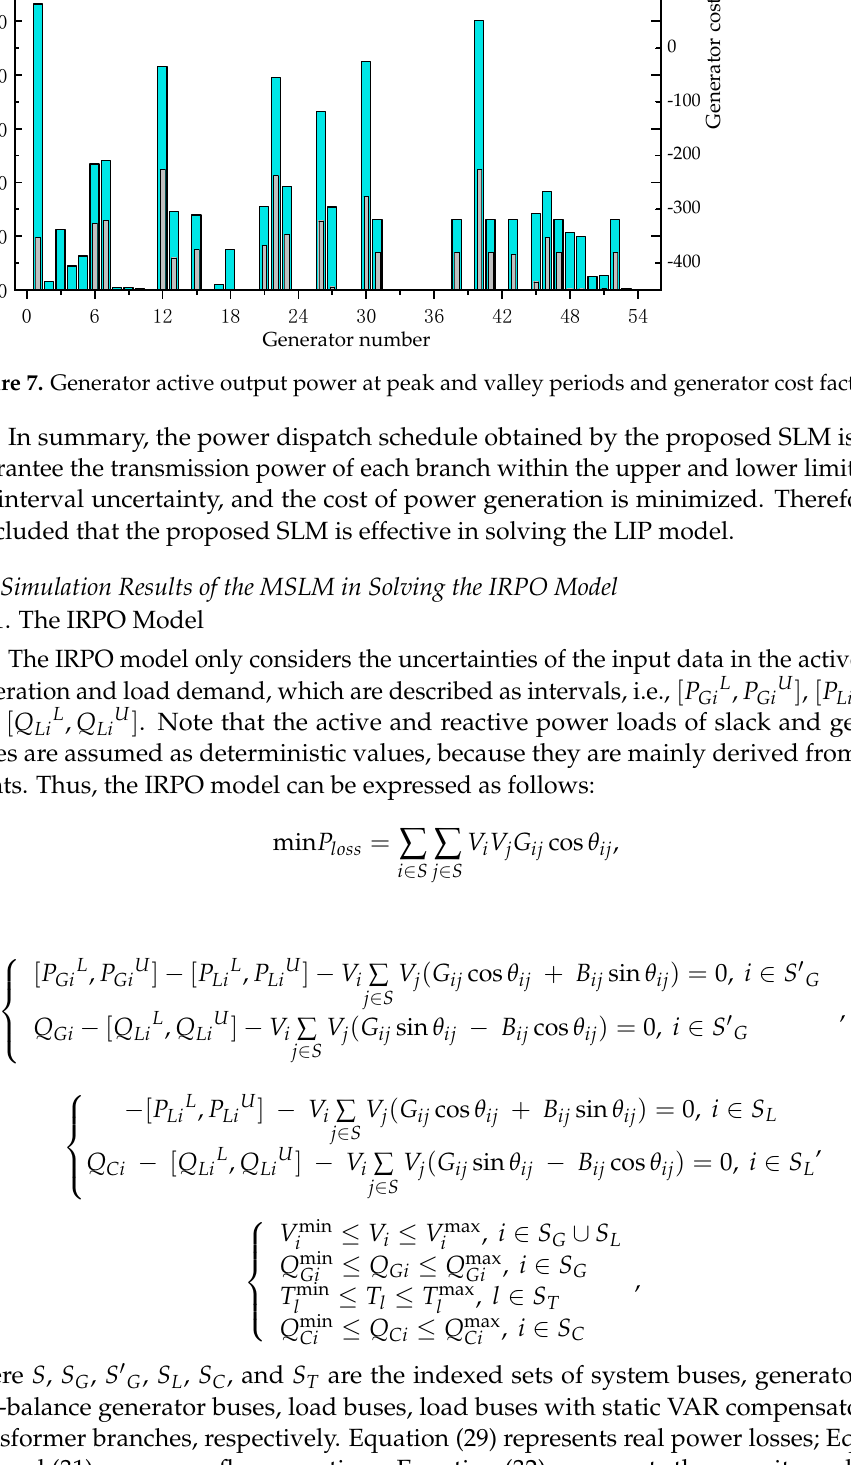
Figure 6. Total load curve at 24 time periods.